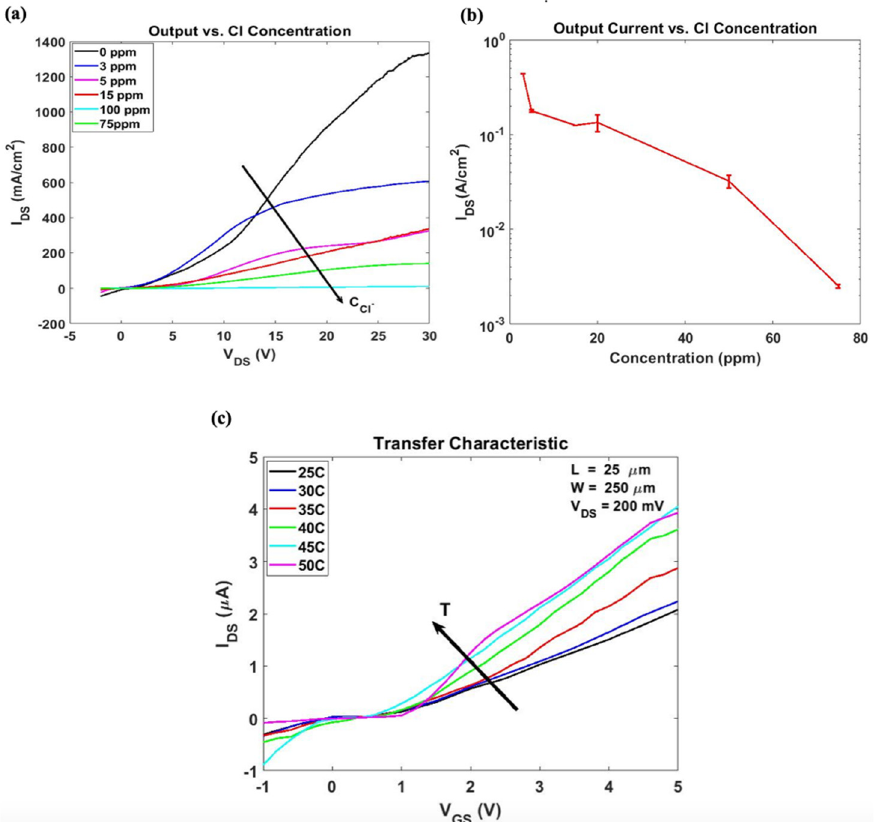
Figure 8 . Hydrogenated graphene-based OTFT Sensor Performance: ( a ) Output characteristic at fixed V GS of 1 V at different chloride ion concentration, ( b ) logarithmic sensor response vs. chloride ion concentration at V GS 1 V and V DS 13 V. ( c ) Sensor ′ s temperature drift.